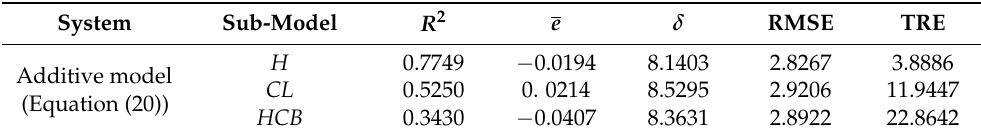
Table 6. Evaluation indices of Equation (20) ( H : total tree height; CL : crown length; HCB : height to live crown base; R 2 : coefficient of determination; e : bias; δ : bias variance; RMSE: root mean square error; TRE: total relative